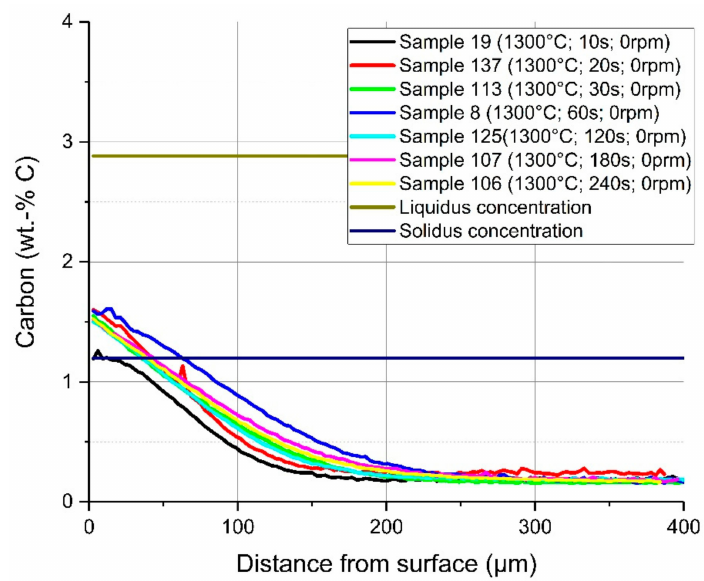
Figure 14. Average carbon composition and di ff usion depth from the detected solid–liquid interface under natural convection in the melt at 1300 ◦ C equilibrium temperature.